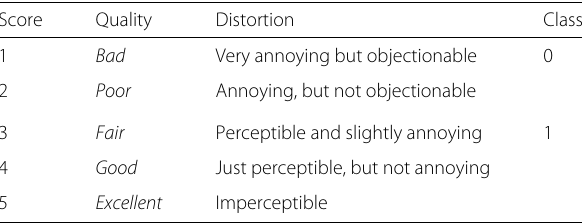
Table 1 Mean Opinion Score (MOS) evaluation